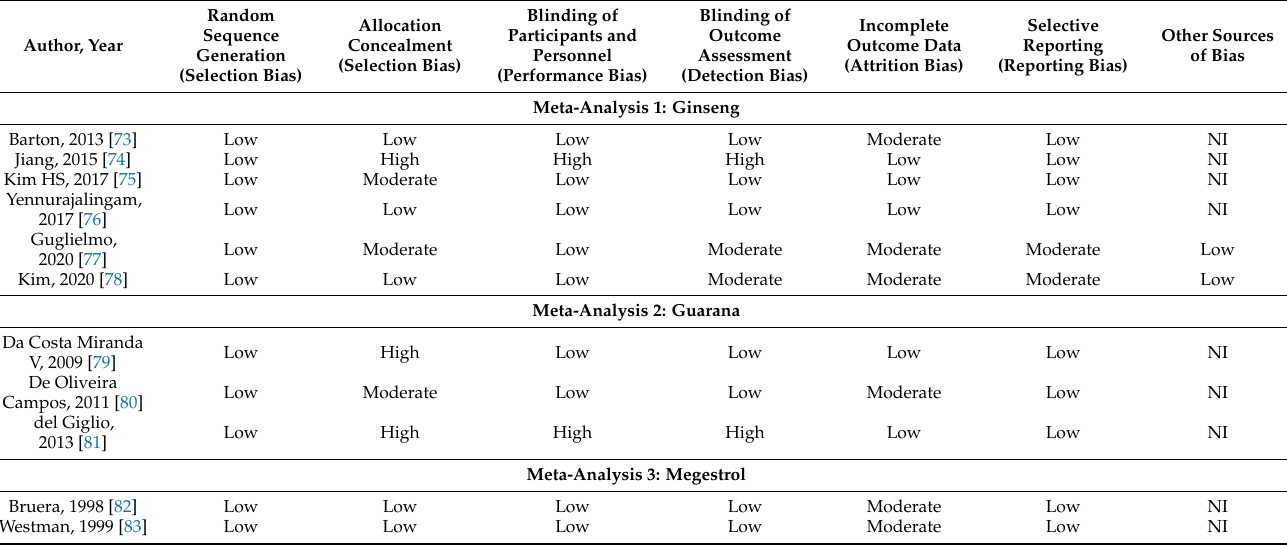
Figure 3. Funnel plot illustrating a scatterplot of study standard errors with relation to treatment effect. Table 2. Risk Bias for Studies Included in the